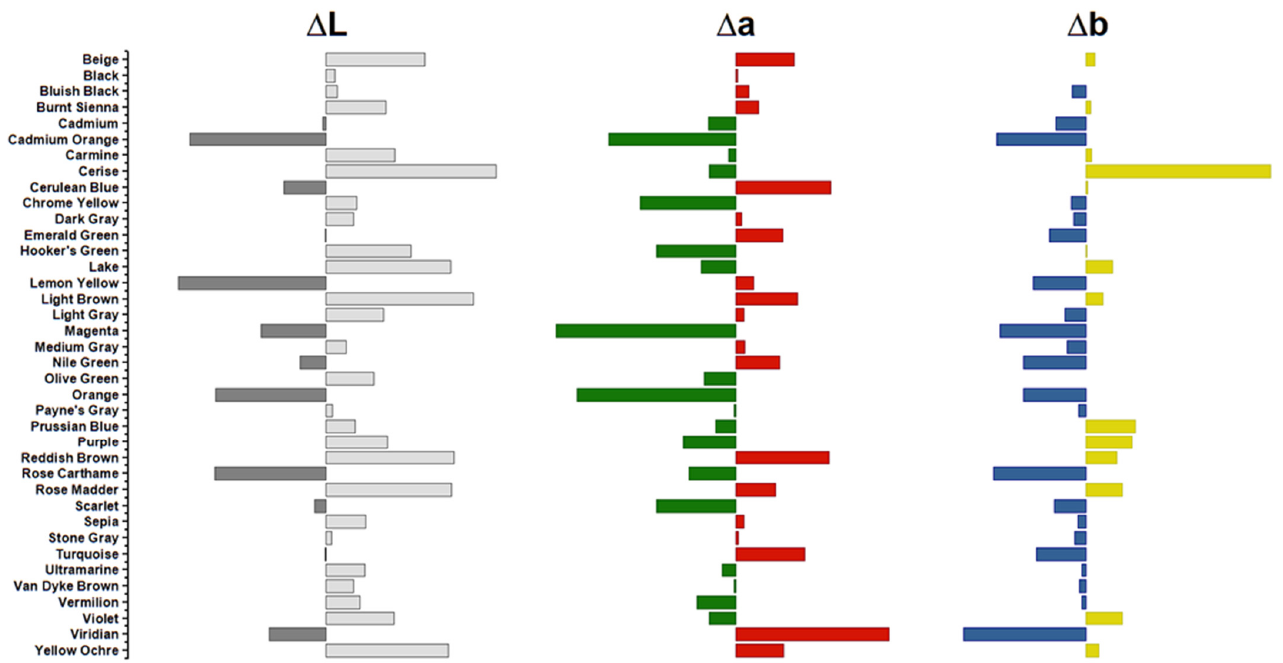
Figure 7. Bar graphs that illustrate the changes observed in Δ L, Δ a, and Δ b for each of the 38 colors in Dr. Ph. Martin’s Synchromatic Transparent Water Colors set.